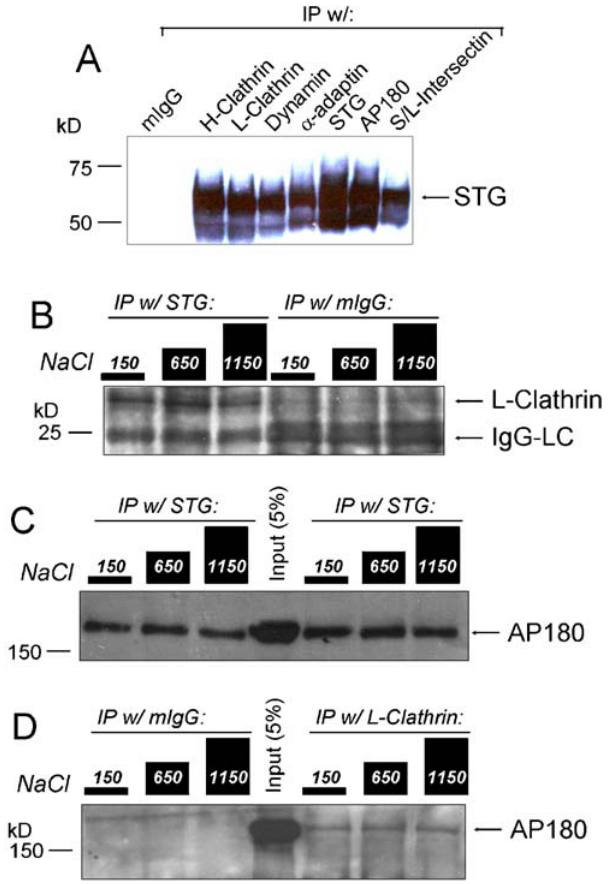
Figure 1. Fractional recovery method.A. Rat brain synaptosome lysate was immunoprecipitated with an antibody against the protein in- dicated above the lanes (the IP-protein). The captured proteins were eluted off the beads and were identified by standard Western blot analysis. Synaptotagmin 1 (STG) was co-precipitated with all of the endocytosis proteins tested. S-/L-intersectin: short/long-variant-inter- sectin. B.–D. After immunoprecipitation as in A , the beads were washed and split into three equal aliquots. Each aliquot was exposed to one of three buffers with different salt concentrations before elution of the remaining bead-attached proteins and analysis by Western blot. In each set of three lanes the left lane was exposed to control 150 mM salt, the center lane to 650 mM and the right lane to 1150 mM salt, as indicated by the diagram at the top. B. Immunoprecipitation of synaptotagmin co-immunoprecipitated L-clathrin ( leftthreelanes ) with only a small reduction at high salt whereas IgG was negative ( rightthreelanes ). C. The fractional recovery method was repeatable. In this panel AP180 was co-precipitated with STG in two separate trials ( leftthreeandright threelanes ) with similar salt-resistant results. D.Figures1Band1C show co-precipitation of L-clathrin with STG and AP180 with L-clathrin and both of these are resistant to high salt treatment. Consistent with these findings, AP180 co-precipitates with L-clathrin ( rightthreelanes ) in a salt-resistant manner whereas IP with IgG is negative ( leftthree lanes ). In C and D the centerlane is 5% of the loading lysate used for the